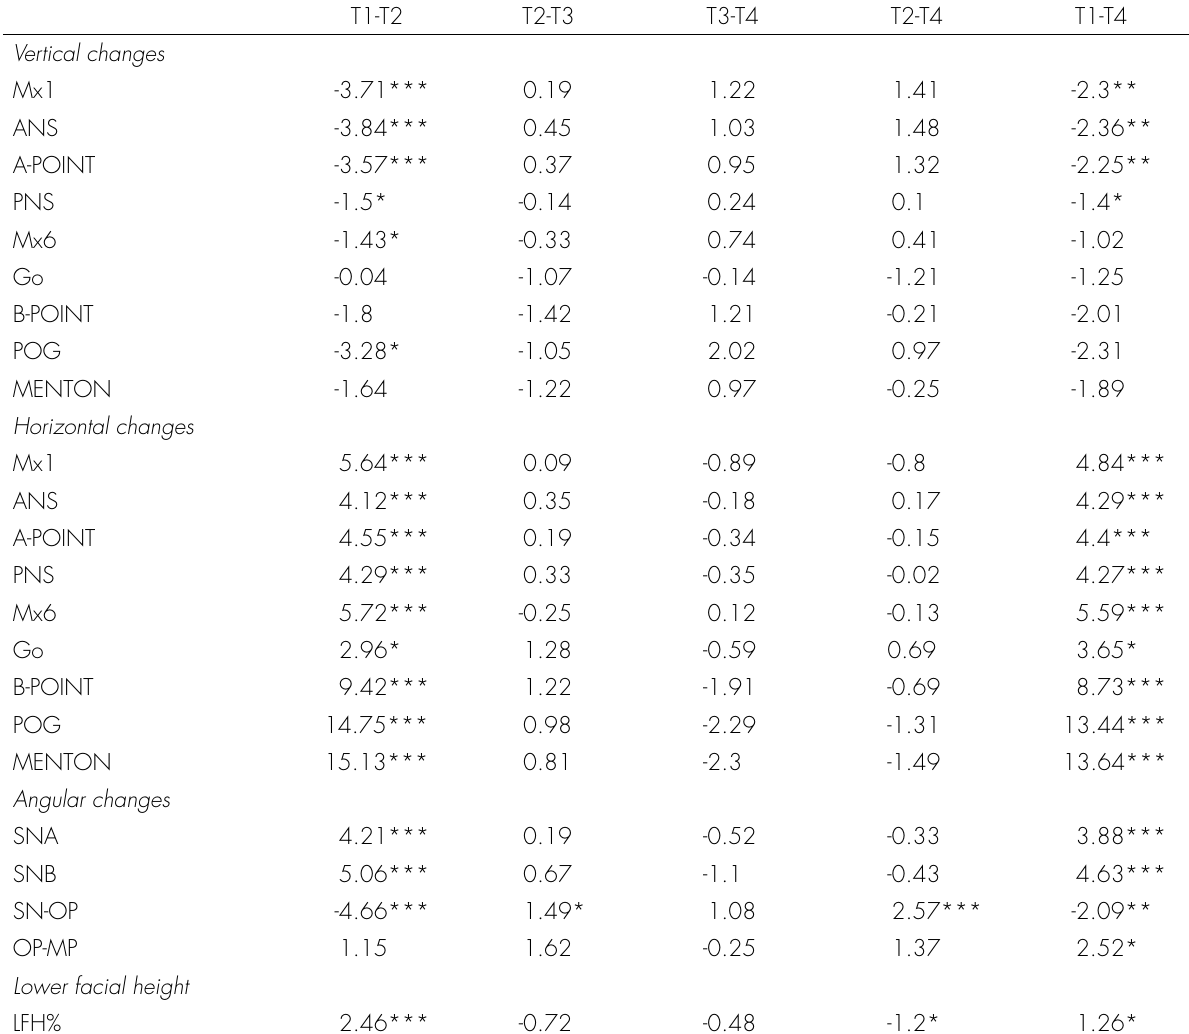
Table IV. Group 3: Anti-clockwise Rotation